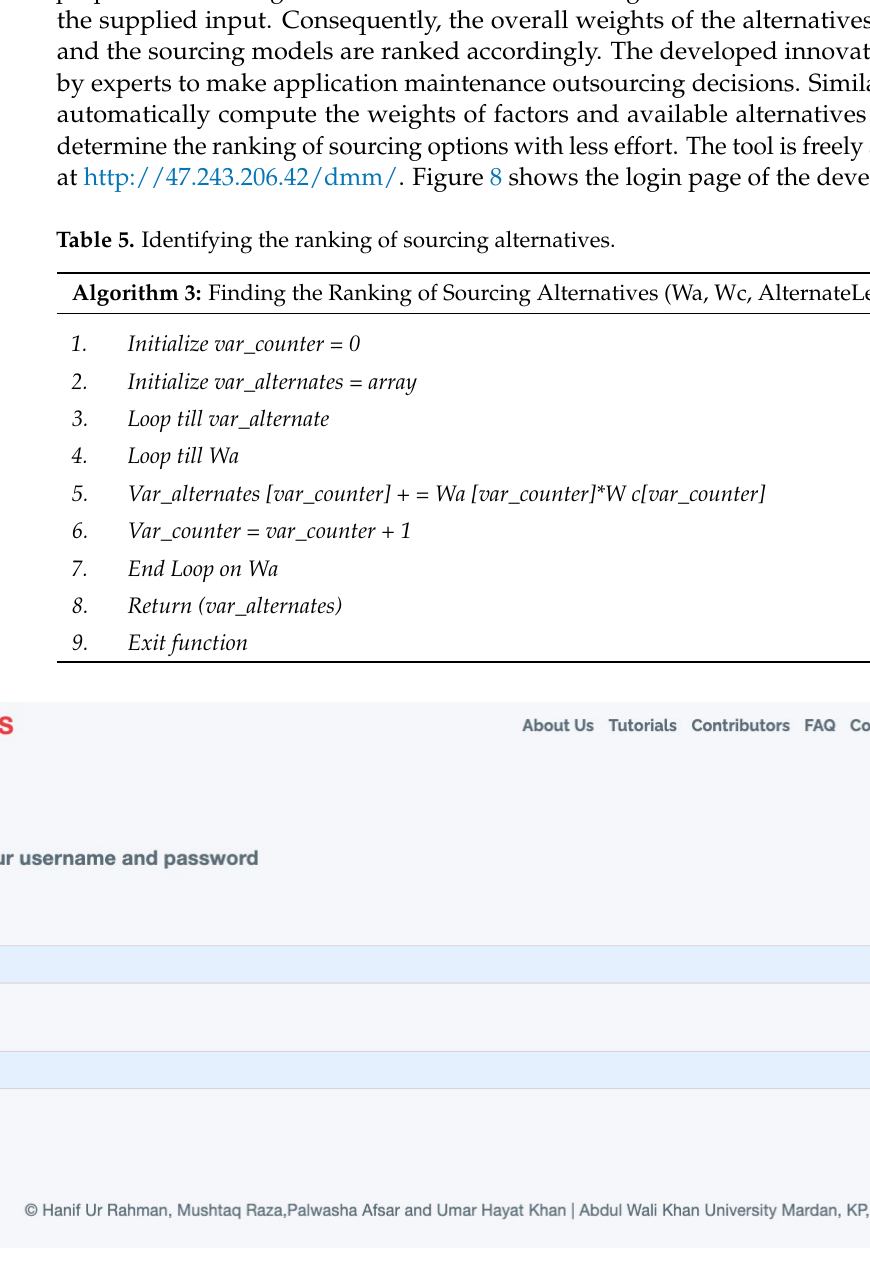
Figure 8. Login page of the proposed tool.